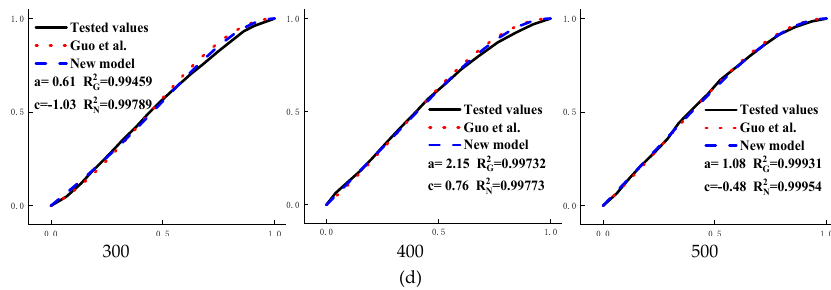
Figure 7. Comparison results between the Guo et al. (1997) model and the new model two: ( a ) high temperature failure of concrete, 300, 600, and 800 are exposure temperatures; ( b ) dry–wet cycle failure of concrete, 120, 240, and 360 are erosion days; ( c ) freeze–thaw cycle failure of concrete, 100, 175, and 200 are freezing-and-thawing times; ( d ) high temperature failure after 25 freeze–thaw cycles of concrete, 300, 400, and 500 are exposure temperatures.